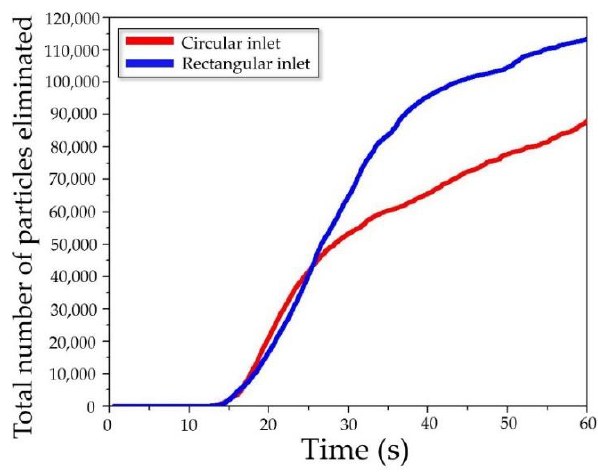
Figure 10. Total accumulated Cr 2 O 3 particles flowing out of the UCT’s outlet.